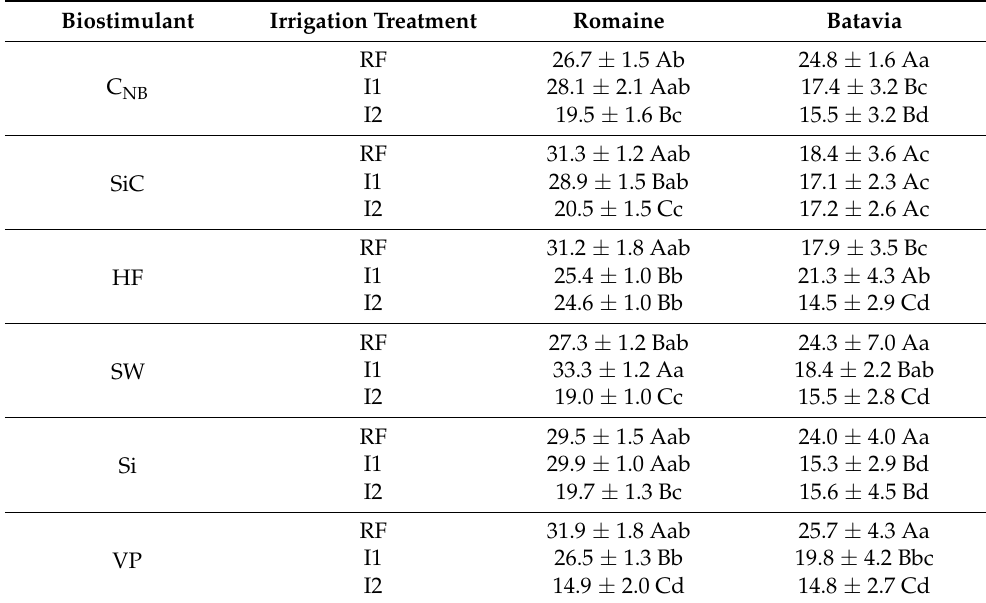
Table 2. Values SPAD index of lettuce plants at harvest (means ± SD). Biostimulant Irrigation